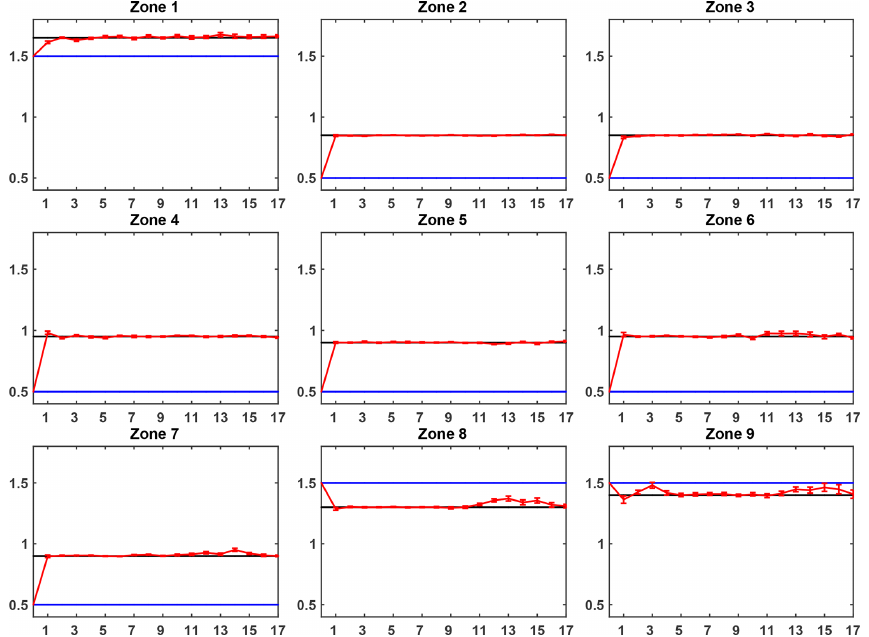
Figure 7. Control variable assimilation results for the PE1 experiment: evolution of the ensemble-averaged analysis control variable (red line) for each zone (one zone per subplot) with respect to the assimilation cycle and compared to the corresponding true value (black line) and the openloop value (blue line).